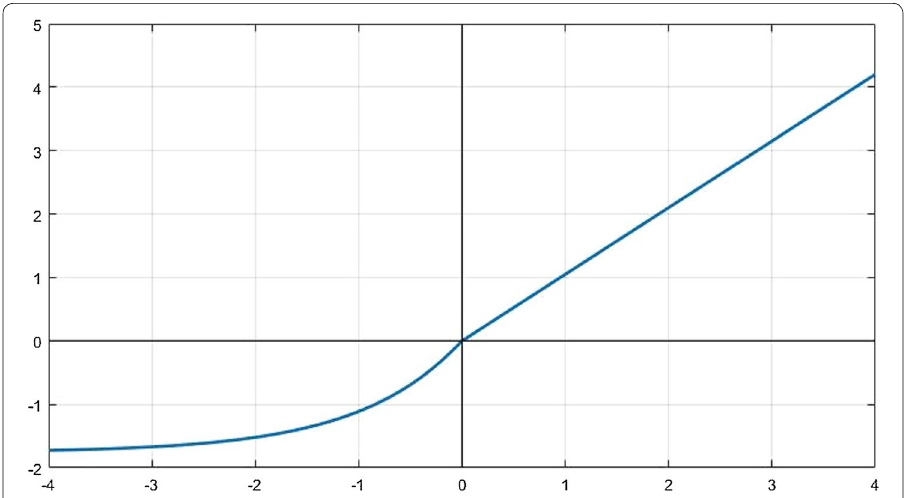
Fig. 6 Scaled exponential linear